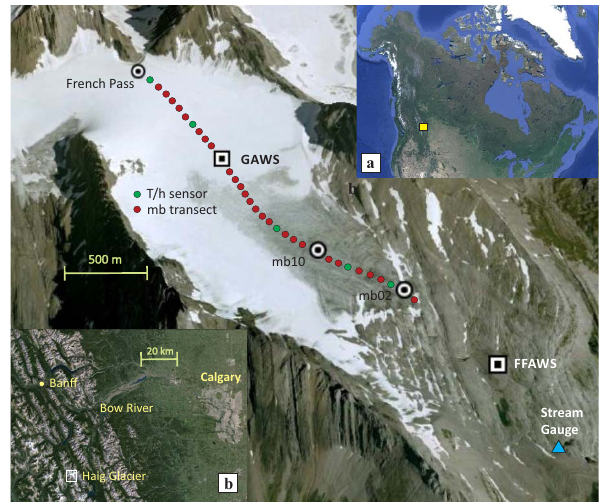
Figure 1. Haig Glacier, Canadian Rocky Mountains, indicating the location of the automatic weather stations (GAWS, FFAWS), ad- ditional snow pit sites (mb02, mb10, and French Pass), the mass balance transect (red/blue circles), the Veriteq T/h stations, and the forefield stream gauge. Inset (a) shows the location of the study site, and inset (b) provides a regional